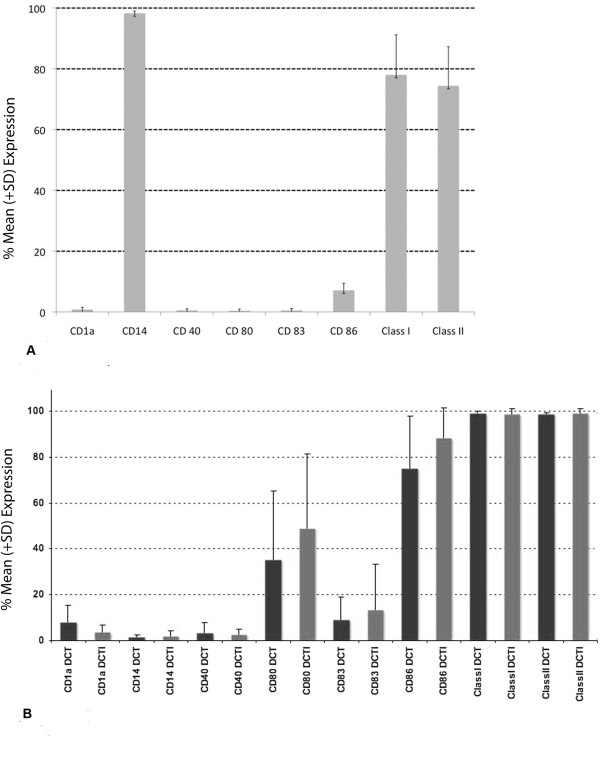
A. Phenotypic profiles of DC precursor CD14+ monocytes. Illustrating the absence of DC markers on this monocyte population. B. DC phenotypic profiles: Expression of DC phenotypic surface markers of DCT compared with DCTI preparations (n = 10); see materials and methods for details regarding DC culture conditions. Statistical analysis did not reveal any statistically significant difference between phenotypic markers for DCT and DCTI.